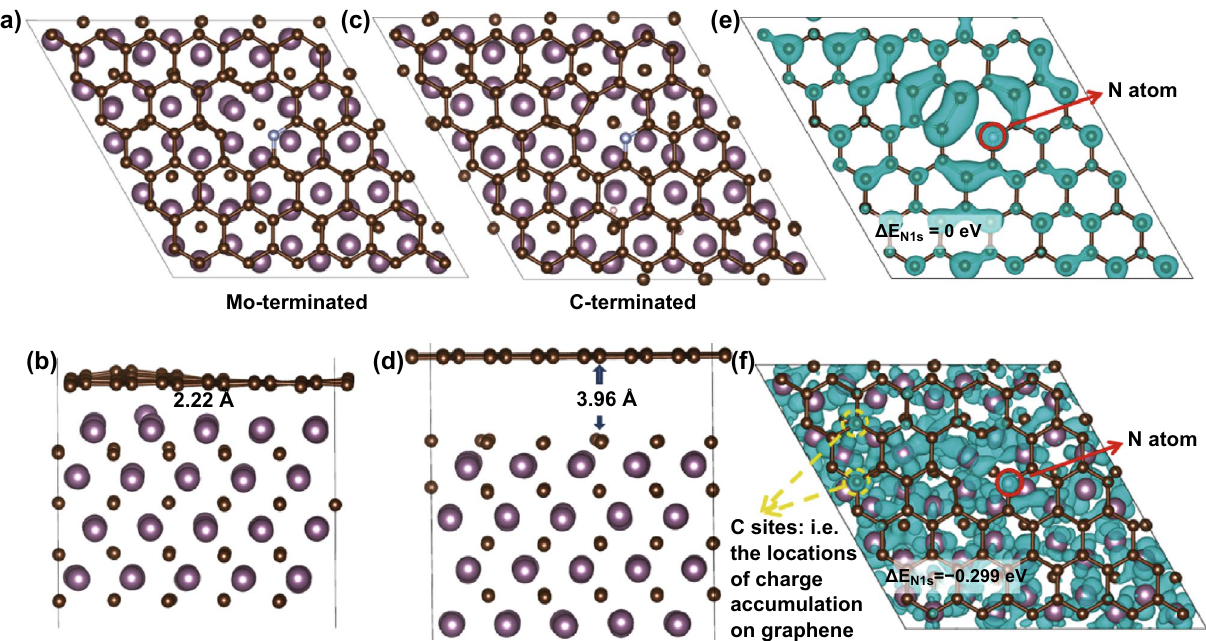
Fig. 1 The a top and b side views of Mo-terminated Mo 2 C@N-doped graphene with pyridinic N dopant; the c top and d side views of C-ter- minated Mo 2 C@N-doped graphene with pyridinic N dopant; the charge distribution of e the unpaired electron of pyridinic N-doped graphene; and f Mo-terminated Mo 2 C@N-doped graphene with pyridinic N dopant. The N atom is circled in red. The locations of charge accumulation on graphene are circled in yellow. The figures are plotted with VESTA [39]